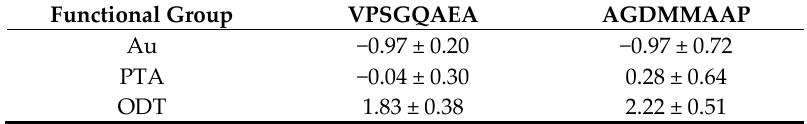
Figure 4. Chemical structure of the PTA/ODT pattern ( a ) Topography image and ( b ) Lateral force image of the PTA/ODT pattern measured using a tip modified with a random peptide ( c ) and benzene-specific peptide ( d ) benzene-specific peptide sequence: N terminus-AAGDMMAAPDP AC- C terminus and random peptide sequence: N terminus-AVPSGQAEADPAC-C terminus. Table 2. Lateral forces in each functional groups with random peptide and the specific